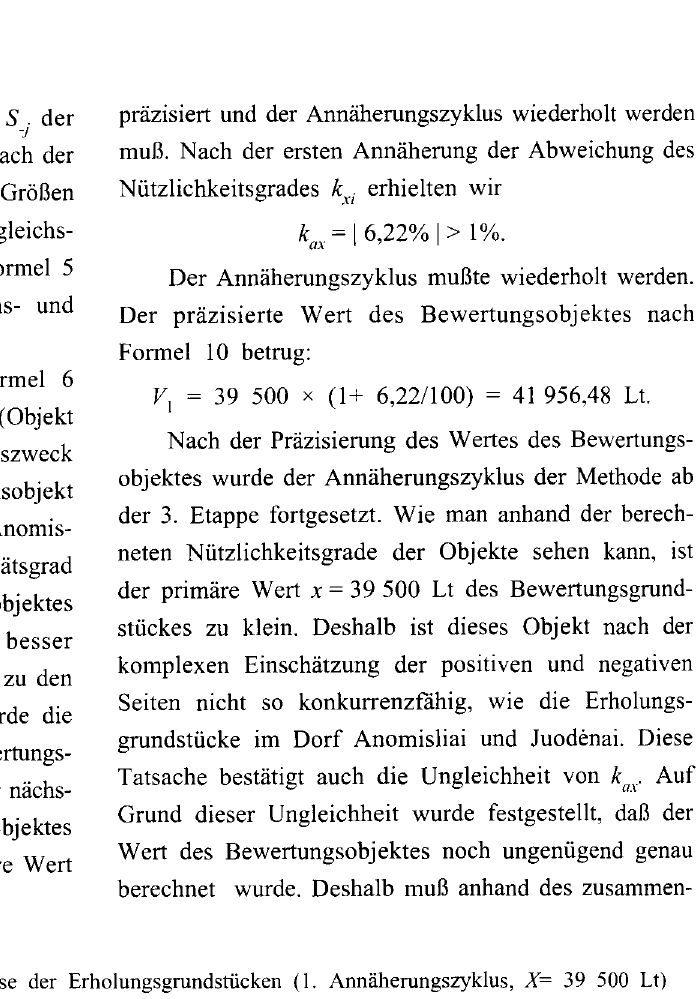
Normalieserte Werle d.. der Kriterien